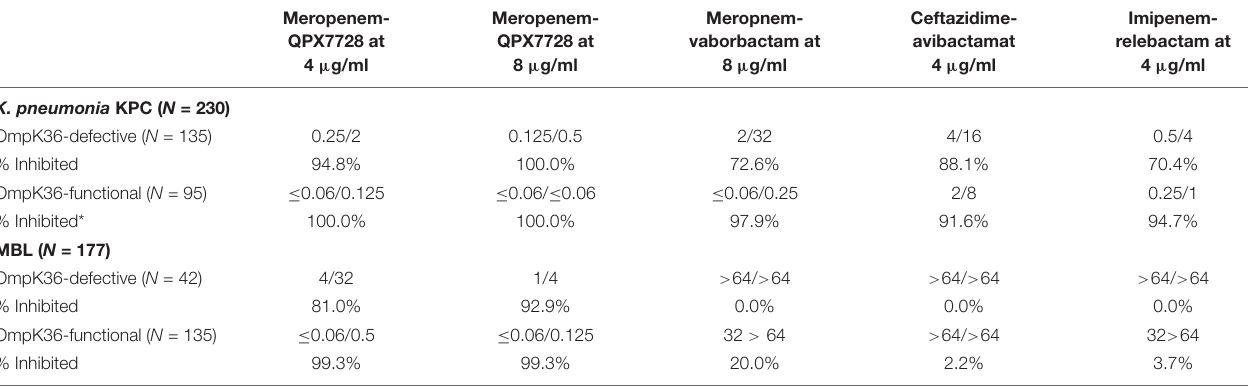
TABLE 5 | In vitro activity (MIC 50 /MIC 90 and % inhibited) of meropenem alone and combined with QPX7728 at 4 and 8 µ g/ml and comparator BLI combination agents against carbapenem resistant strains of Enterobacterales according to the functional status of OmpK35/OmpF and OmpK36/OmpC and carbapenemase present.